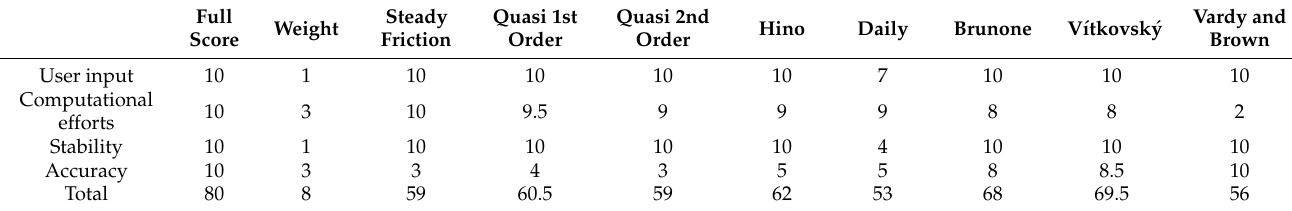
Table 7. Weighted average comparison between friction models.